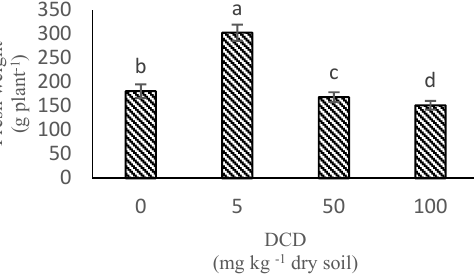
Figure 3. The main effect of dicyanodiamide in lettuce plant fresh weight. (The means refer to four repetitions ± SD. Different letters for each parameter indicate significant differences assessed ( p < 0.05).)